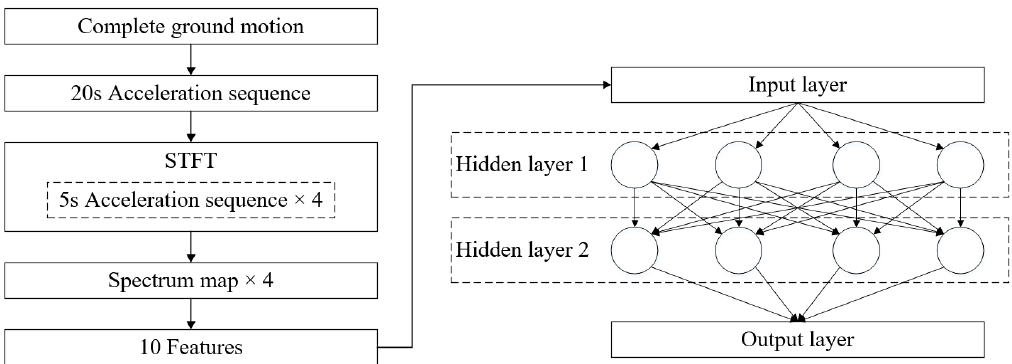
Figure 9. Feature extraction and network architecture.